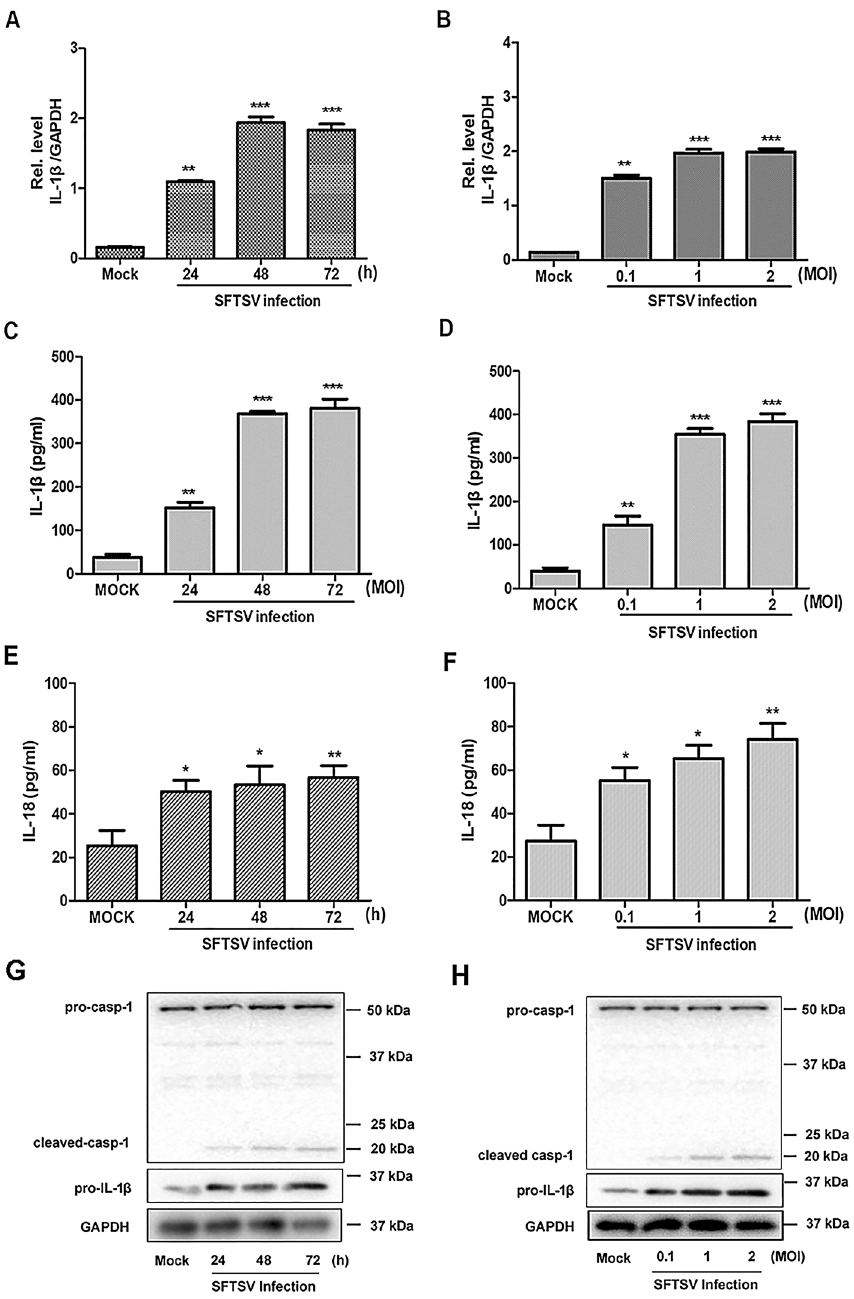
Figure 2. Induced upregulation or processing of pro-IL-1β, IL-18 and pro-caspase 1 in PBMCs infected with SFTSV. PBMCs were isolated from healthy individuals and infected with SFTSV at an MOI = 1 for 24, 48, or 72 h ( A , C , E ) or for 48 h at an MOI = 0.1, 1, or 2 ( B , D , F ). IL-1β and GAPDH mRNAs were quantified by RT-PCR with specific primers for IL-1β and GAPDH, respectively ( A , B ). IL-1β and IL-18 levels in the culture medium of PBMCs infected with SFTSV were determined by ELISA ( C , D , E , F ). Upregulation of pro-IL-1β and processing of cleaved caspase-1 (p20) were determined by western blot with specific antibodies for pro-IL-1β and cleaved caspase 1 (p20), respectively ( G , H